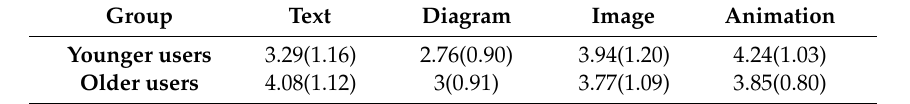
Table 13. Means and standard deviations for comprehension (standard deviation in parentheses, unit: points; five-point Likert scale).